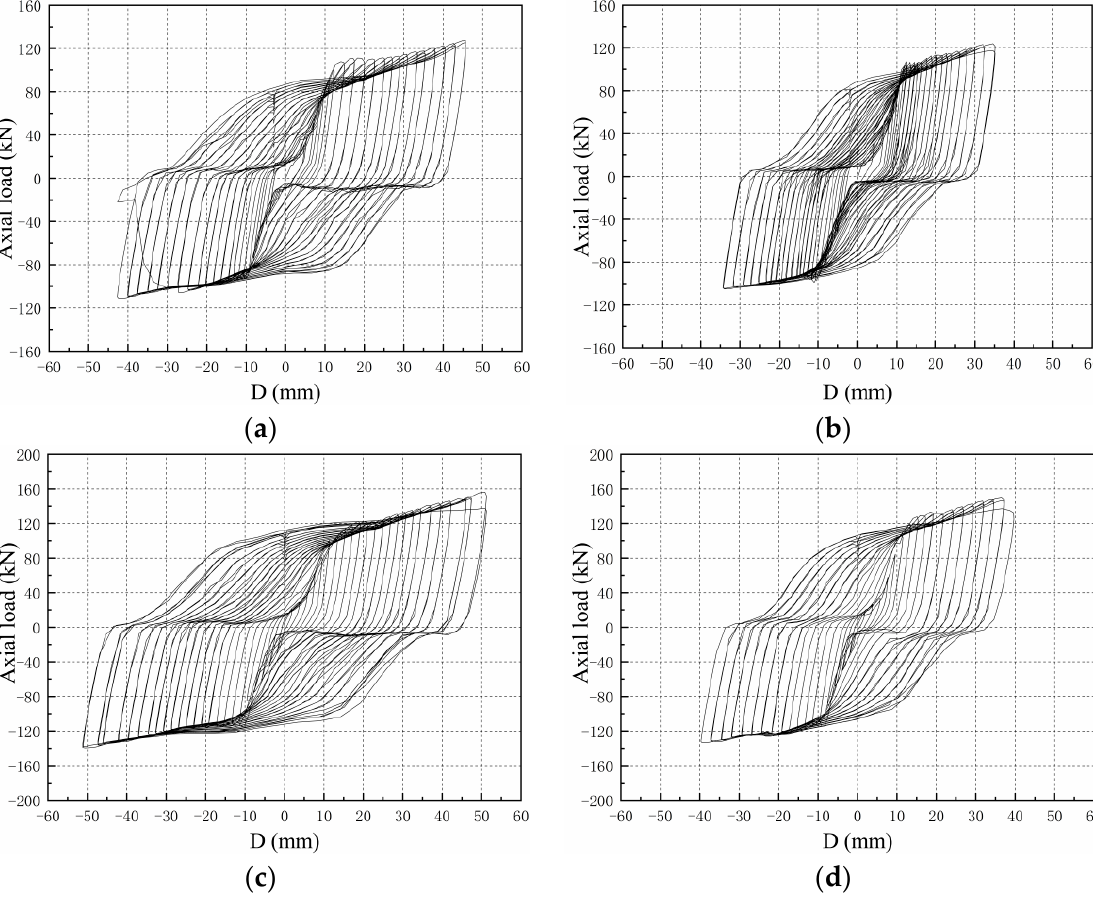
Figure 10. Hysteresis curves of the specimens: ( a ) S1; ( b ) S2; ( c ) S3; and ( d )